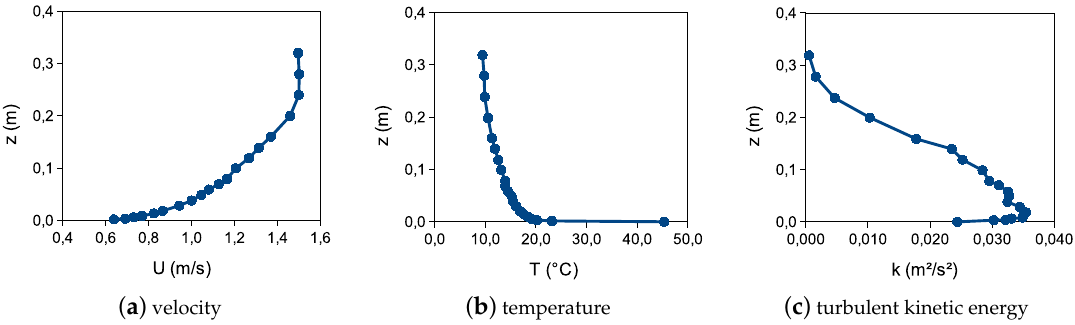
Figure 8. Inlet profiles for the isolated building located in an unstable boundary layer.